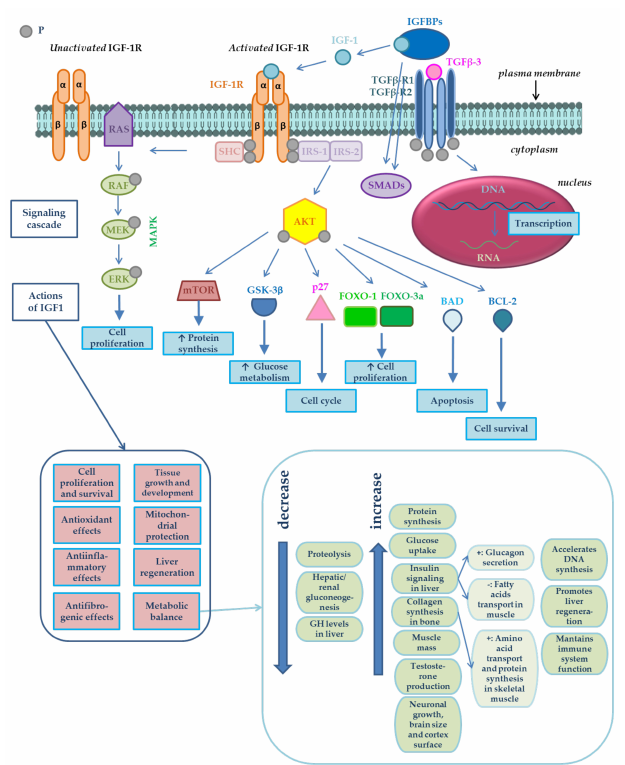
Figure 1. Signaling cascade of insulin-like growth factor 1 (IGF-1) and its potential impacts in metabolism, its interactions with transforming growth factor β 3 (TGF- β 3) and the biological functions of the IGF1 , IGFBP2 and TGFß3 genes. IGF-1 bioavailability is modulated by IGF binding proteins (IGFBPs) [15]. IGF-1 action is mediated by its binding to its receptor [16], the type 1 insulin-like growth factor receptor (IGF-1R). IGF-1R is a heterotetramer composed of two extracellular α subunits and two transmembrane β subunits, as shown in Figure 1. α subunits are cysteine-rich regions, whereas β subunits possess a tyrosine kinase domain, which constitutes the signal transduction mechanism [16]. Tyrosine phosphorylation activates a signaling cascade[17]. IGF-1hasautocrine,paracrine[18,19]andendocrineeffects[18]. IGF-1bindstoitsreceptor(IGF-1R) in the cell membrane, resulting in autophosphorylation and the recruitment of the adaptor proteins–insulin receptor substrate IRS-1, IRS-2, and the proto-oncogene tyrosine-protein kinase (SRC) homology and collagen protein (SHC). The serine / threonine kinase (AKT) is activated by the 3-phosphoinositide-dependent protein kinase-1 (PDK1) and by the mammalian target of rapamycin (mTOR)-containing complex mTOR-C2, leading to the phosphorylation at threonine 308 and serine 473, respectively. Activated AKT regulates downstream signaling molecules such as tuberous sclerosis protein 1 / 2 (TSC-1 / 2), which inhibit mTOR-C1 complex and regulate the ribosomal protein S6 kinase 1 / 2 (S6K-1 / 2) and eukaryotic translation initiation factor 4E (eIF4E)-binding protein 1 (4EB-P1) phosphorylation, FOXO transcription factors, glycogen synthase kinase-3 β (GSK-3 β ), p27,BCL-2antagonistofcelldeath(BAD),andBCL-2. Thesesubstancesareinvolvedinsomecellular processessuchasproteinsynthesis, glucosemetabolismandcellsurvival. SHCactivationinducestheactivation of the RAS / mitogen-activated protein (MAP) kinase pathway, resulting in enhanced cell proliferation [15]. Activation of IRS induces the activation of intracellular RAF / MEK / ERK / RAS and PI3K signaling pathway. The first mentioned pathway mediates mitosis, and the second one mediates metabolism and cell growth effect through AKT [20]. After the ligand (IGF-1) binds to its receptor (IGF-1R), PI3K is activated, cell proliferation by inducing the phosphorylation and the inhibition of proapoptotic proteins such as BAD [21]. The protein IGFBP-2 encoded by the gene of the same name is able to control the biological actions of IGFs [22] and TGFß [23] in vivo via the endocrine, autocrine or paracrine pathways. The protein TGFß-3 encoded by the TGF β 3 gene controls the growth, proliferation and differentiation of cells, cell motility and apoptosis. TGFß-3 plays an essential role in the development of skeletal muscles. It also can suppress the formation of tumors